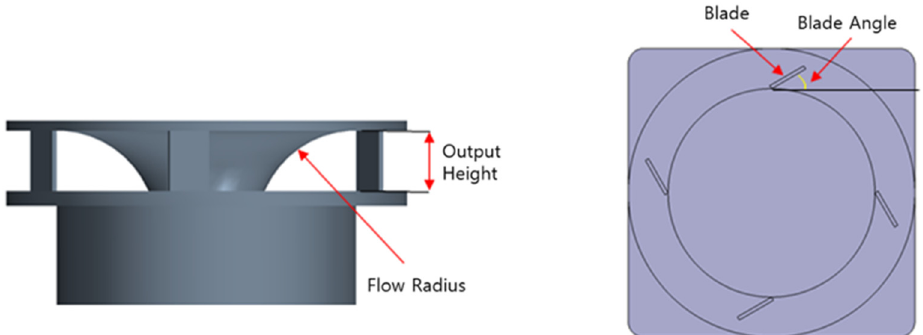
Figure 3. Outlet design parameters. Table 1. Levels and design variables.